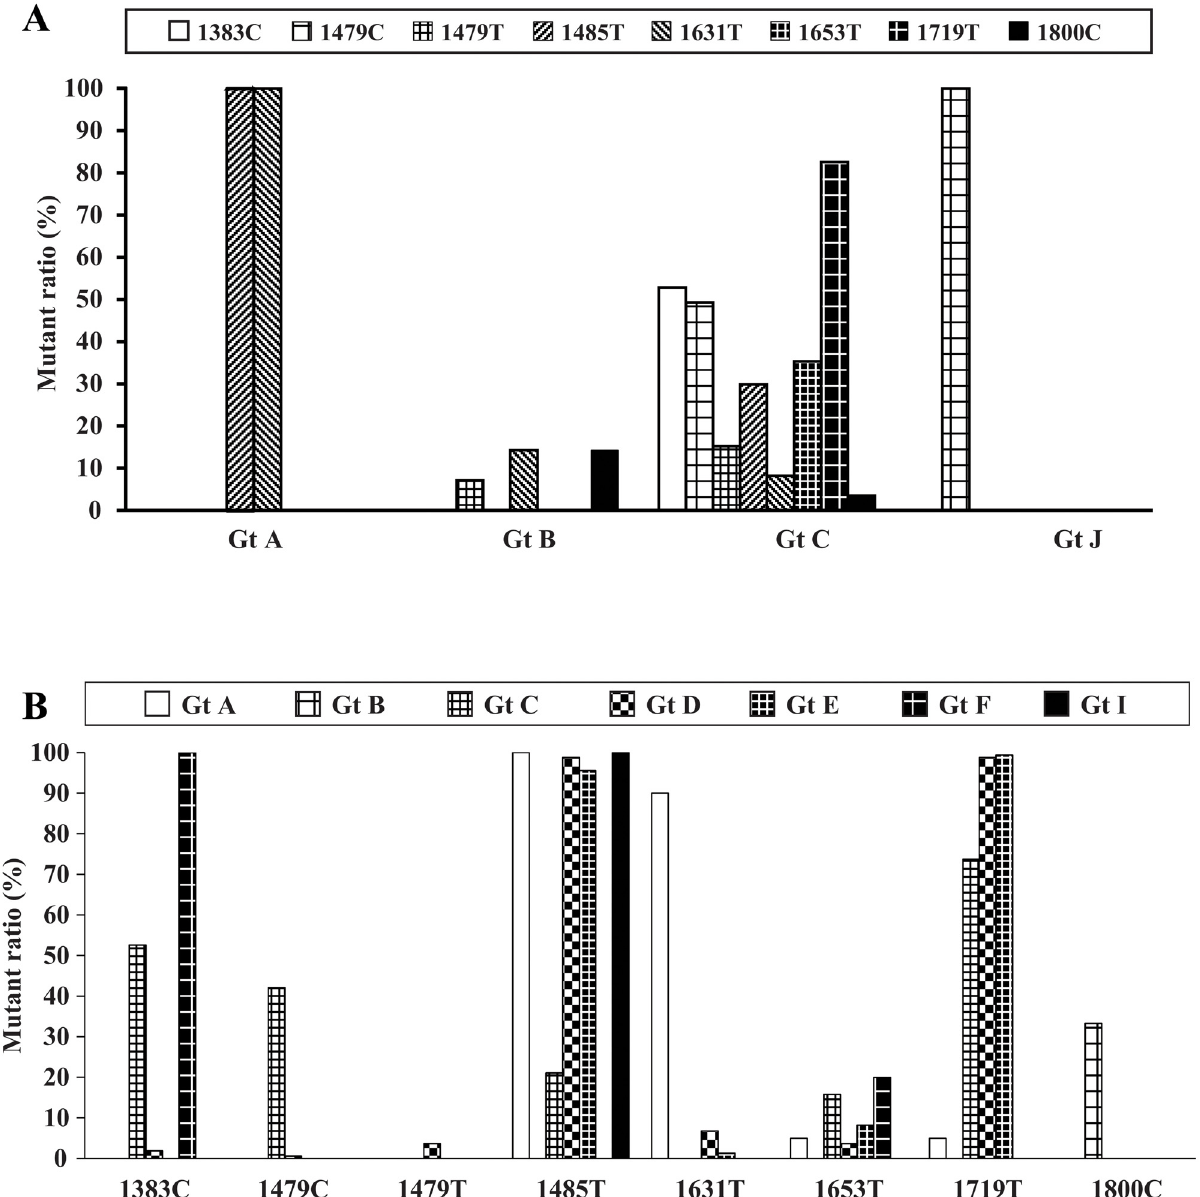
Fig 3. Distribution of genotype C HBx mutations for HCC. The data among HCC with different genotypes (A) and among ASC with different genotypes (B) were analyzed. (A) In genotype A HCC sequences (n = 2), two positions (1485T and 1631T) showed 100% genotype C HCC risk nucleotides. Genotype J HCC sequence (n = 1) presented one position with 100% genotype C HCC risk nucleotide (1479C). In genotype B HCC sequences (n = 14), three positions (1479T, 1631T and 1800C) showed the genotype C HCC risk nucleotides at relatively lower ratios less than 20%. (B) In ASC sequences (genotype A: 20, genotype B: 3, genotype D: 161, genotype E: 158, genotype F: 5, genotype I: 1), 1485T were frequently observed in genotypes A, D, E, and I, and 1631T and 1800C were in genotype A (90%) and B (33.3%), respectively. 1383C and 1719T were seen in genotype D and F, respectively, together with genotype